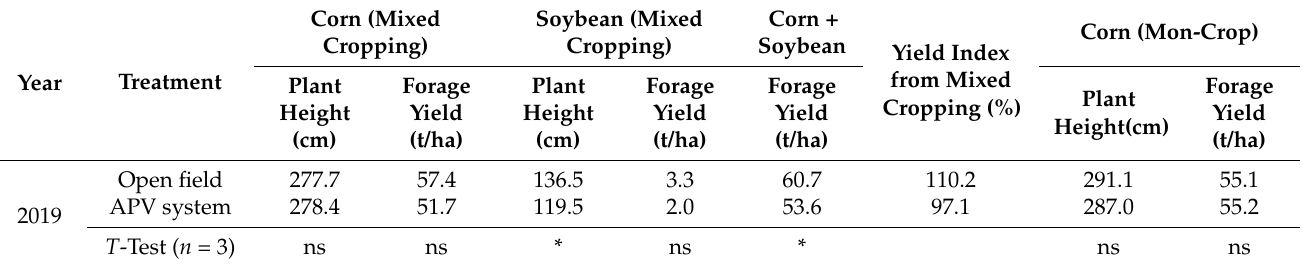
Table 5. Mean of forage yield test for the corn mono-crop and the mixed planting of corn and soybean between the agro-photovoltaic system and the open field over two